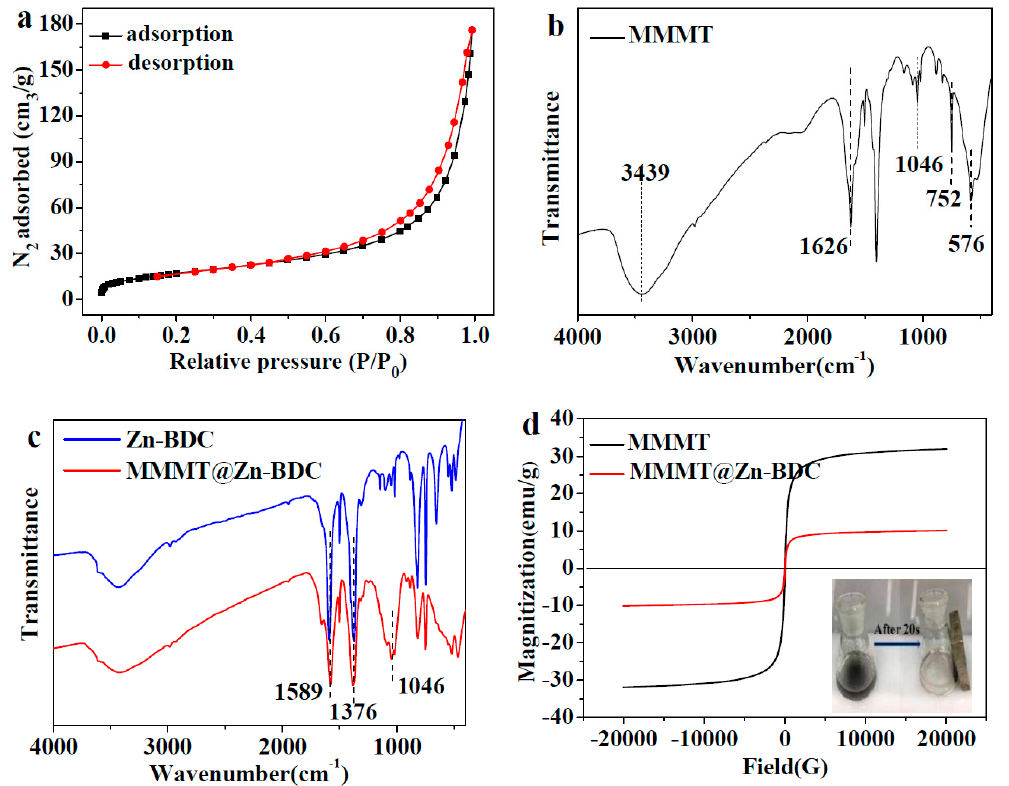
Figure 4. ( a ) N 2 adsorption and desorption test for MMMT@ Zn-BDC ; FTIR spectra of ( b ) MMT, ( c ) Zn-BDC and MMMT@ Zn-BDC , ( d ) VSM magnetization curves of MMMT and MMMT@ Zn-BDC ( c ) Zn-BDC and MMMT@Zn-BDC, ( d ) VSM magnetization curves of MMMT and MMMT@Zn-BDC (inset: MMMT@ Zn-BDC before and after application of a magnetic field for 20 s). (inset: MMMT@Zn-BDC before and after application of a magnetic field for 20